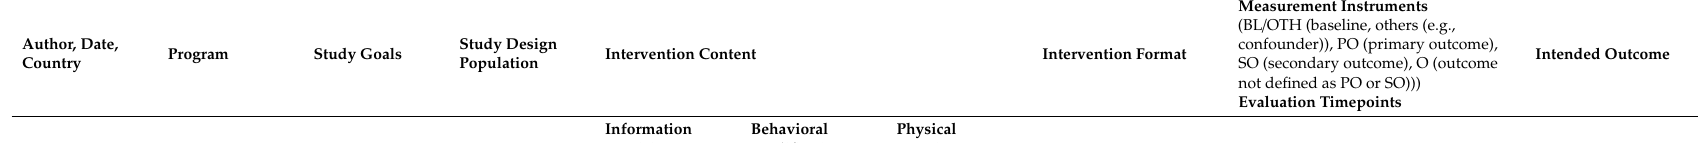
Table 3. Evaluation concepts for future